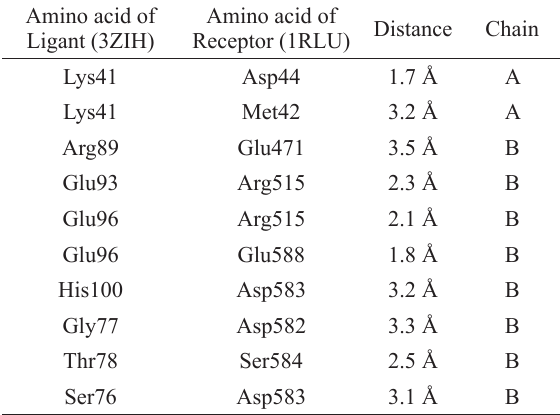
Amino acid relationship between interaction SepF and